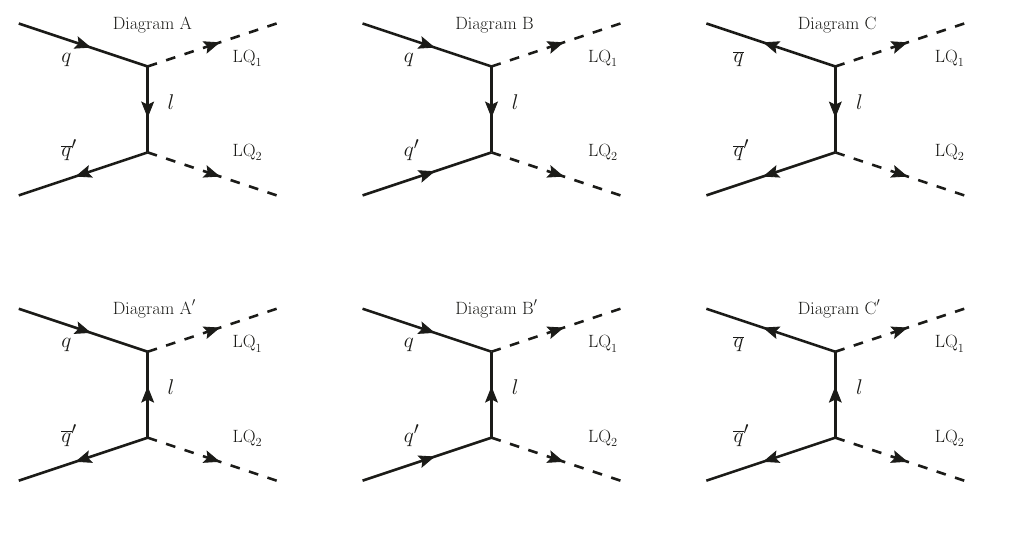
, and LQ for ∆ F = 1 2 ) | − | F (LQ ) | = 0 are specified in tables 2 and 3, 1 2